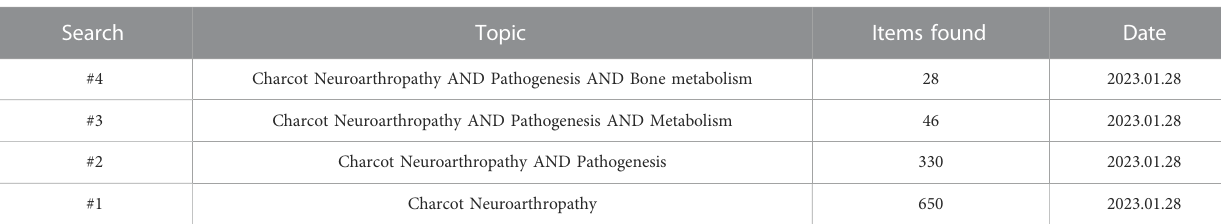
TABLE 1 The comparison of different search topics. Search Topic Items